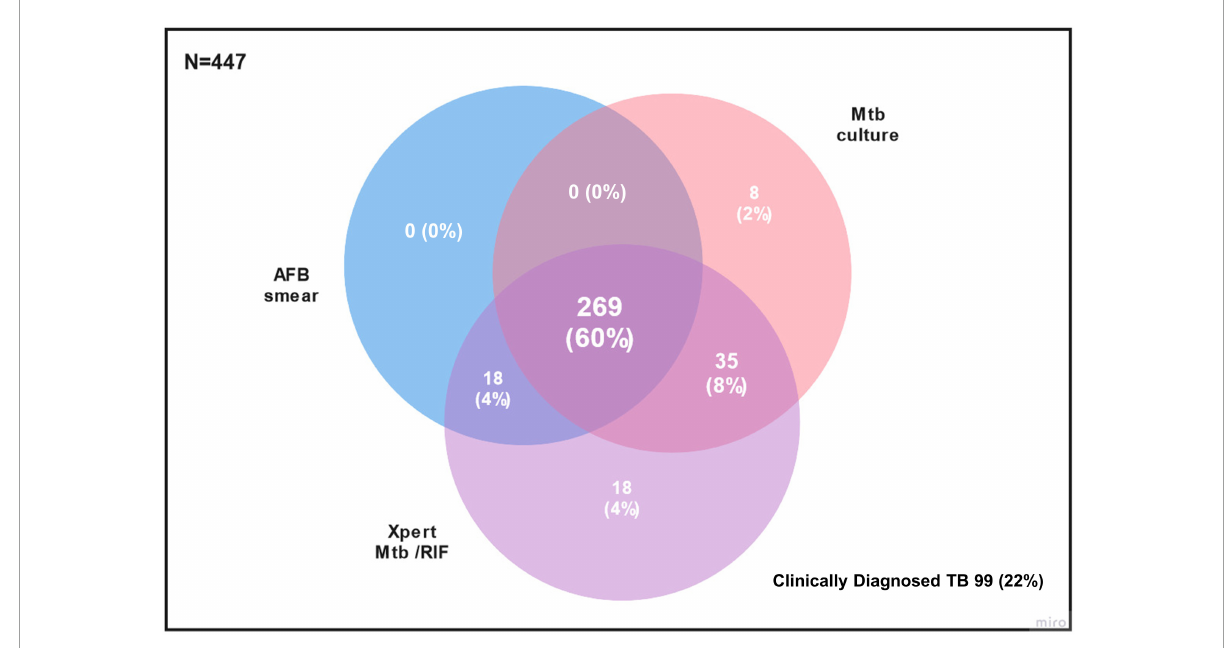
FIGURE1 Case distribution by diagnostic methods. Number of participants are shown as n (%).